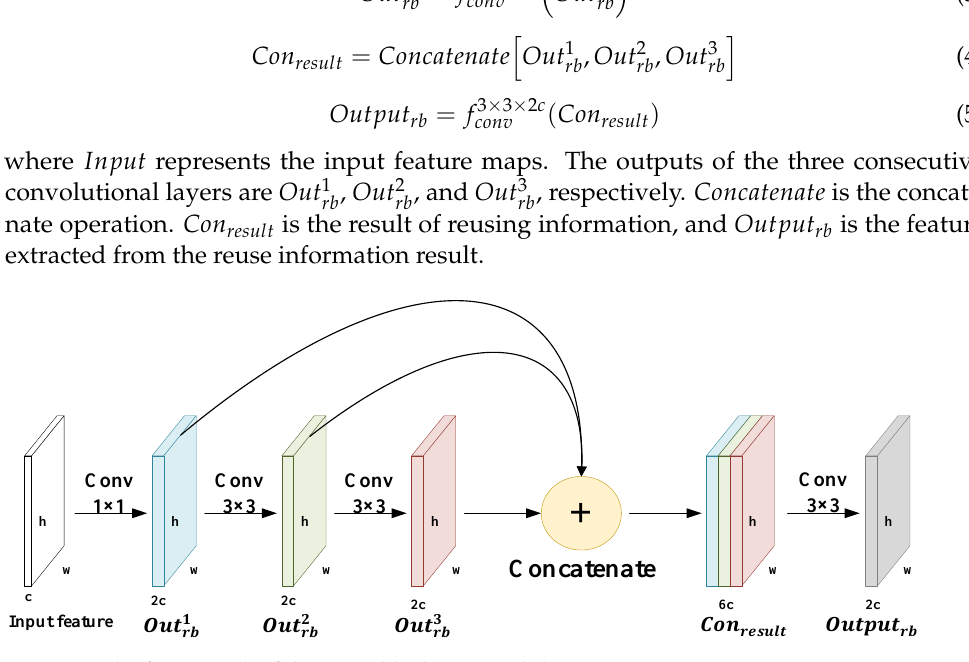
Figure 3. The framework of the reuse block (RB